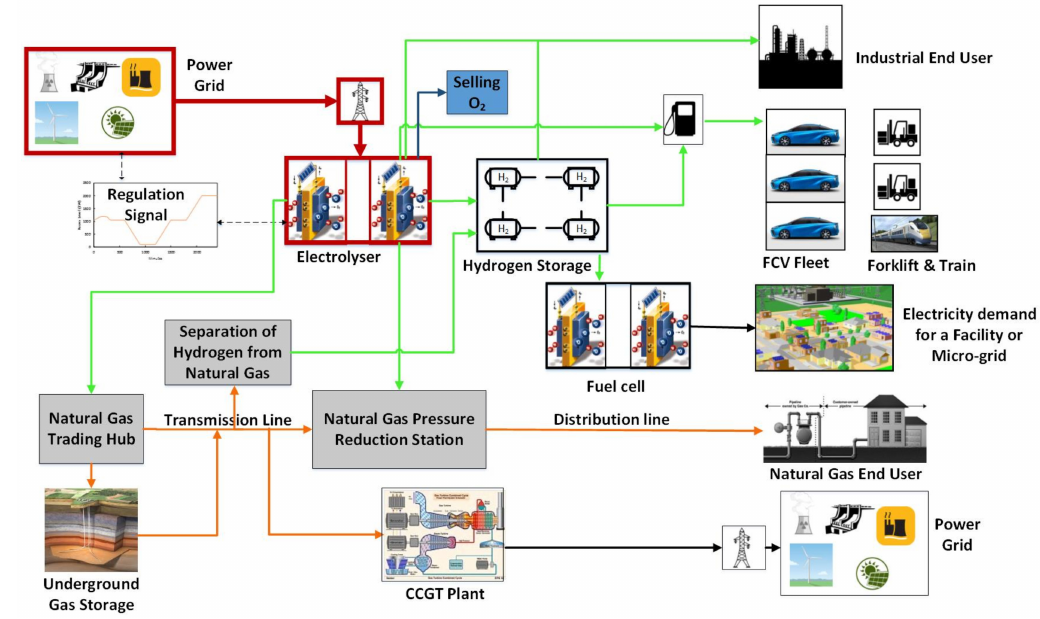
Figure 1. Schematic view of